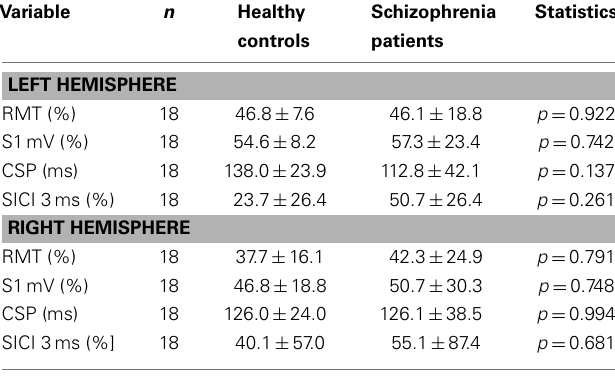
Table 2 |TMS baseline